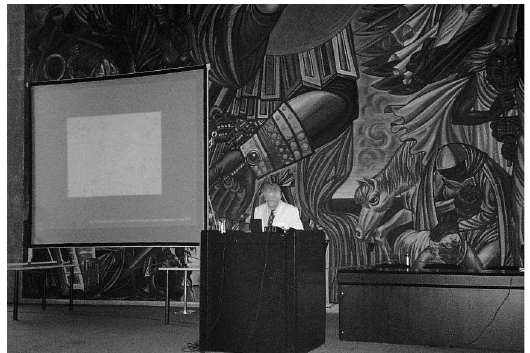
Figure 7 (right below): Prof. Sandro Forconi deliver- ing the plenary Fahraeus lec- ture in the National Palace